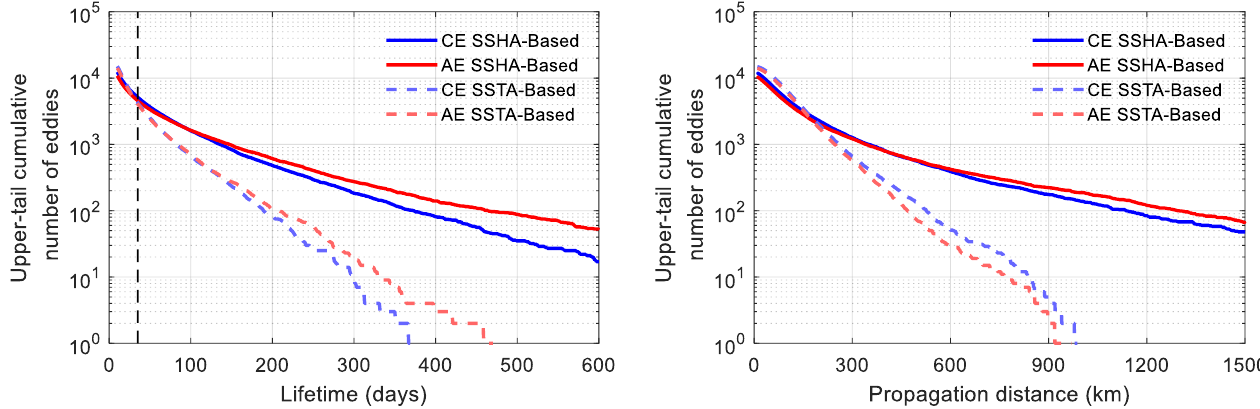
Figure 7. The upper-tail cumulative histograms of the lifetime ( left ) and the propagation distance ( right ) of cyclonic (CE) and anticyclonic (AE) eddy trajectories, respectively. The black dashed line represents the cutoff lifetime of 30 days; eddy trajectories with lifetime < 30 days are ignored in the following research.